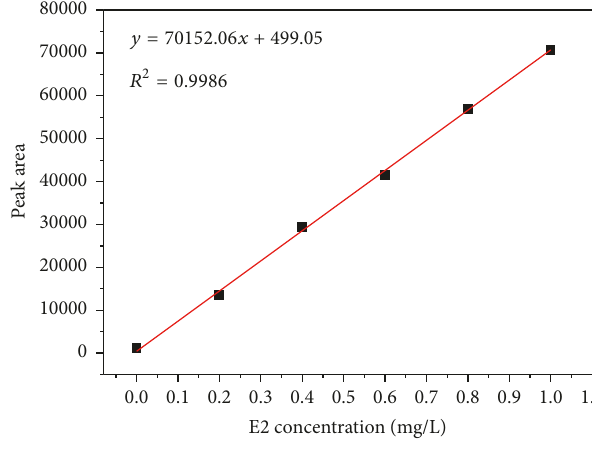
Figure 2: The calibration curve for